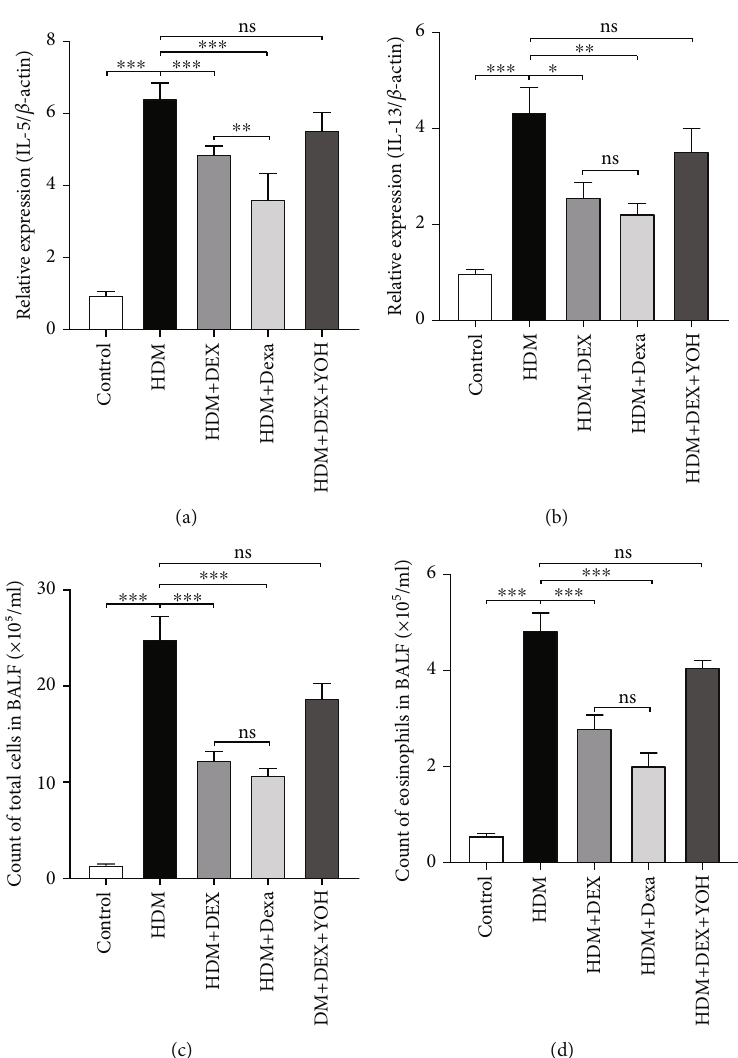
Figure 2: DEX treatment reduced the expression levels of in fl ammatory cytokines in lungs and inhibited in fl ammatory cell in fi ltration in BALF. (a, b) Cytokine gene expression assayed by RT-qPCR in lungs. (c, d) Comparison of total cell numbers and eosinophils in BALF. Data were presented as mean ± SEM ( n = 5~ 8 animals). ∗ P < 0 : 05 , ∗∗ P < 0 : 01 , and ∗∗∗ P < 0 : 001